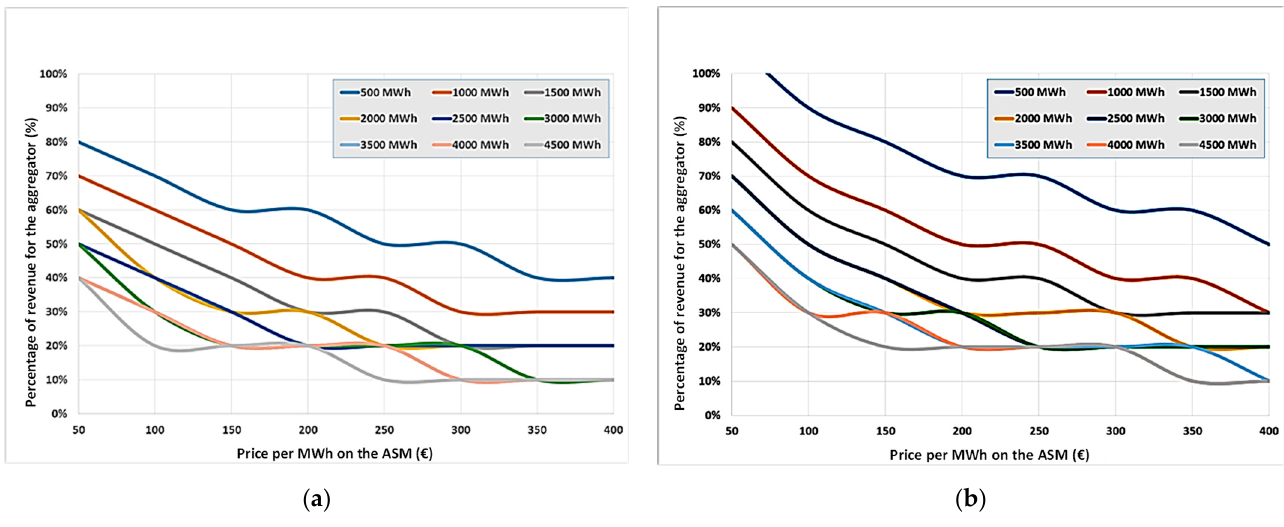
Figure 8. Comparison of the profit curves for the aggregator, as the costs of the management platform vary ( a ) EMP costs = 0 and COM costs = 0; and ( b ) EMP costs = 115 and COM costs =